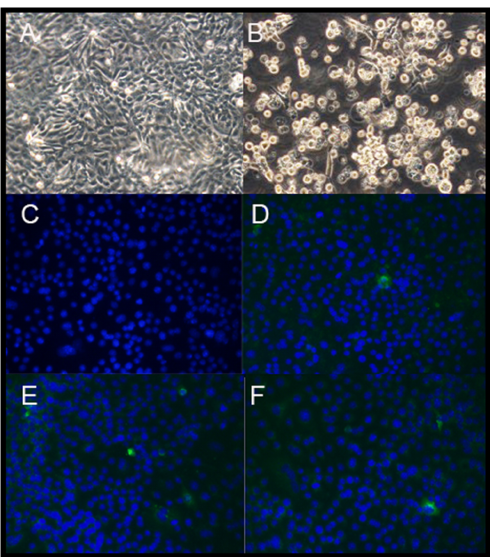
Figure 2. The rescue of the recombinant PDCoVs (magnification, 100×). LLC-PK1 cells transfected with N transcript only ( A ) and the full-length mRNA genome and N transcript of PDCoV ( B ) at 72 h post electroporation (hpi) viewed by light microscopy. IF staining for cells inoculated with control ( C ), icPDCoV ( D ), icPDCoV-RBD ISU ( E ), and icPDCoV-S HKU17 ( F ) at 24 hpi [PDCoV N gene (in green) and nuclei (in blue)].